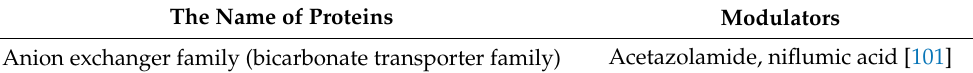
Table 1. Proteins that regulate bicarbonate dynamics involved in carcinogenesis with its potential